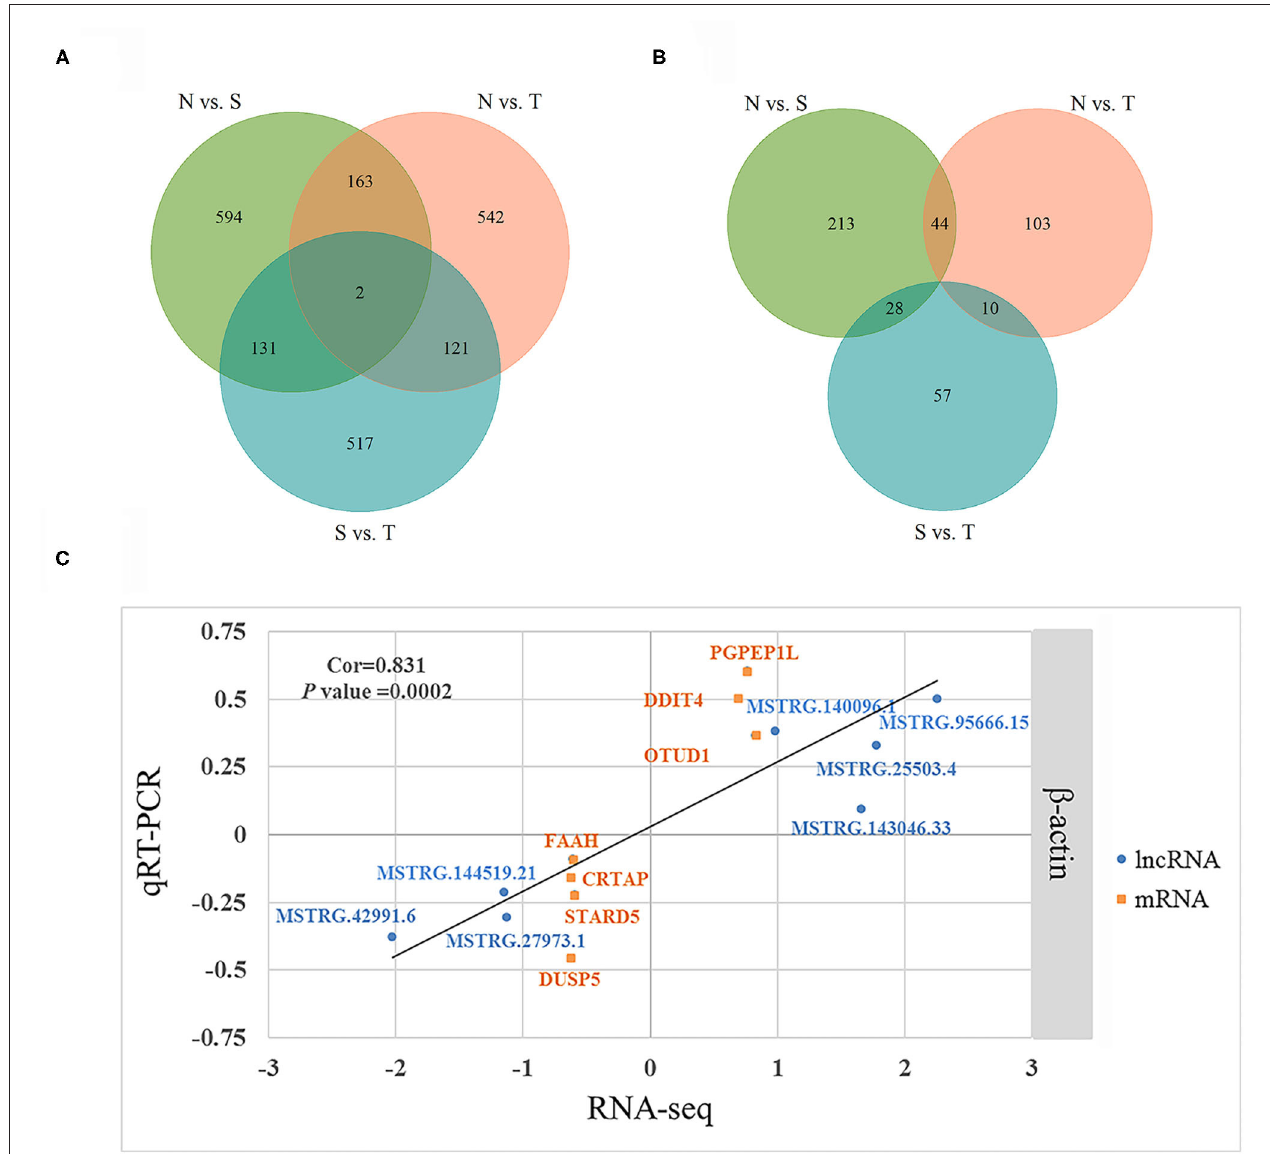
FIGURE 3 | Differentially expressed (DE) lncRNAs and DE genes among birds during Trichomoniasis gallinae infection. (A) Venn diagram of DE lncRNAs among control (N), susceptible (S), and tolerant (T) birds. (B) Venn diagram of DE genes among control (N), susceptible (S), and tolerant (T) birds. (C) Correlations of gene expression level of 7 DE genes and 7 DE lncRNAs using RNA-Seq and qPCR. The x- and y-axis represent the relative expression levels measured by RNA-seq and qPCR, respectively. β -actin were used as internal control. The orange and blue dots represent the DE genes and DE lncRNAs,